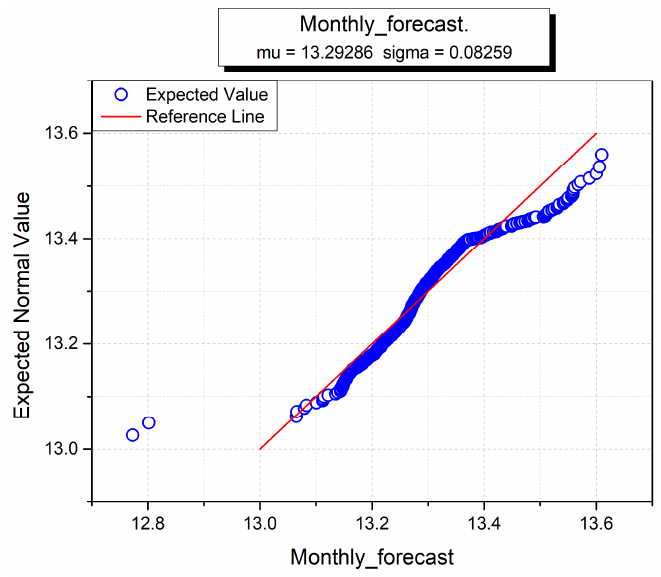
Figure 16. Monthly normal distribution for wind power forecasting.